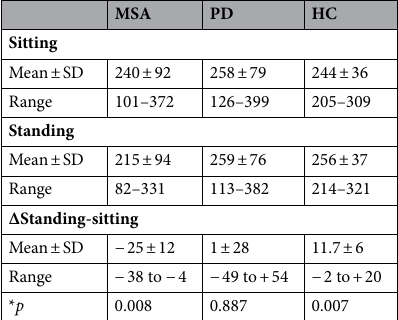
Table 4. Choroidal sub-foveal thickness (in µm) among different groups. * p = Wilcoxon test.